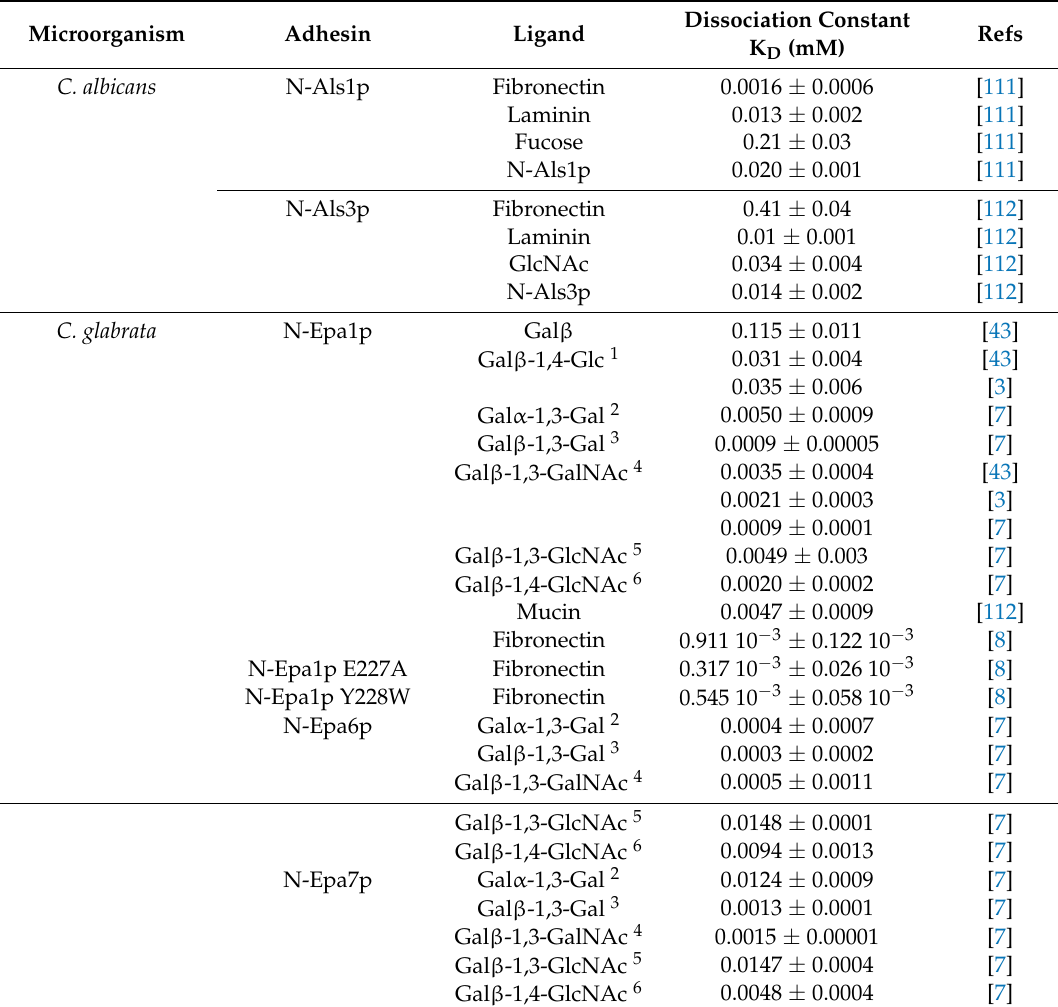
Table 2. Affinities (equilibrium dissociation constants K D ) for the interaction between the yeast adhesins and their